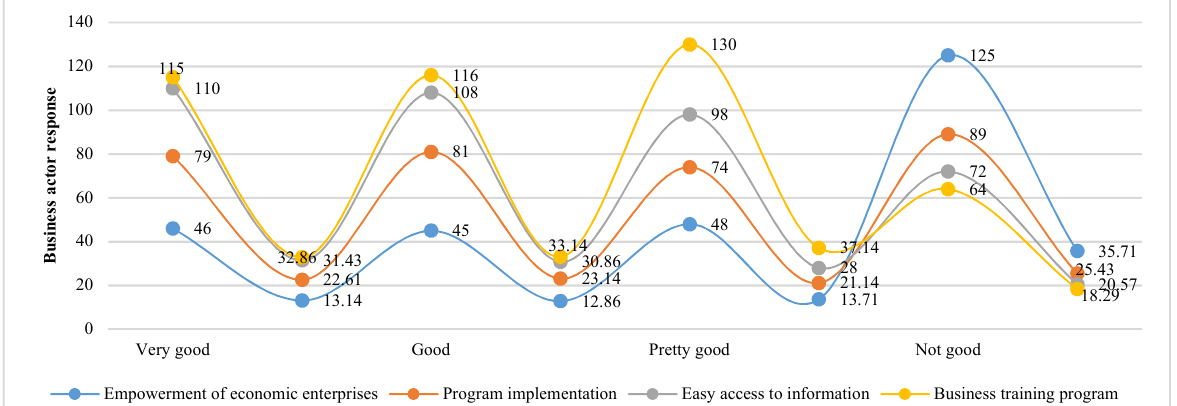
Figure 5. Respondents’ perceptions of the performance of government programs in SMEs. Source: primary data.